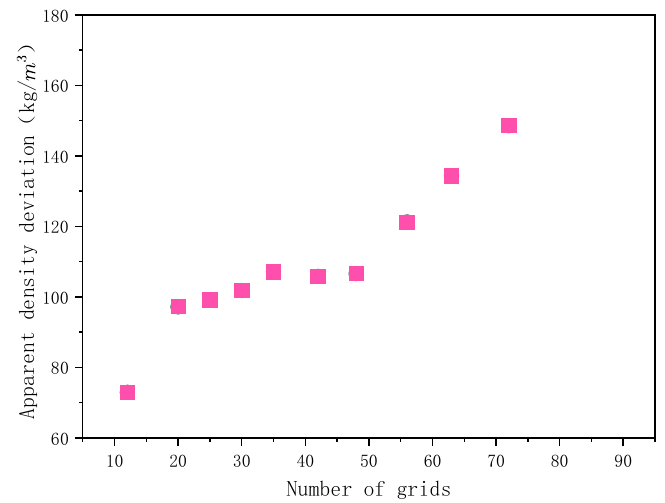
Figure 3. Influence of grid number on standard deviation of the density.